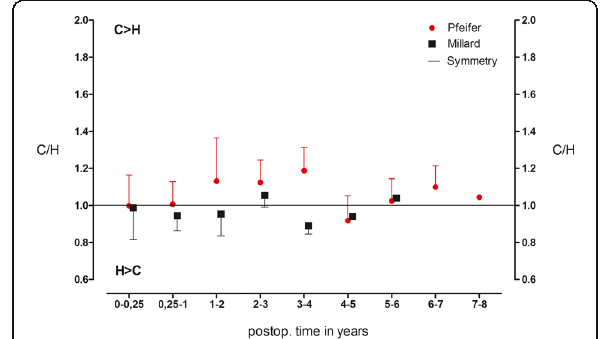
Fig. 6 Relation of mouth width. Symmetry quotient of mouth width in the Millard group ( n = 36) compared to the Pfeifer group ( n = 44) ( p = 0.156). Presented as the means± standard deviation